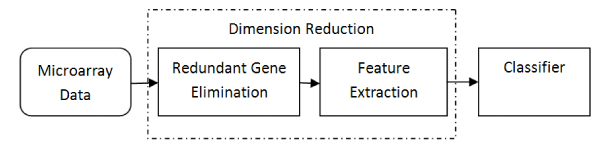
The novel framework of dimension reduction.